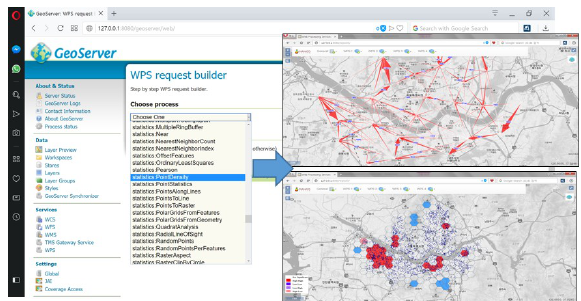
Figure 3. GeoServer WPS extension with Spiral 3